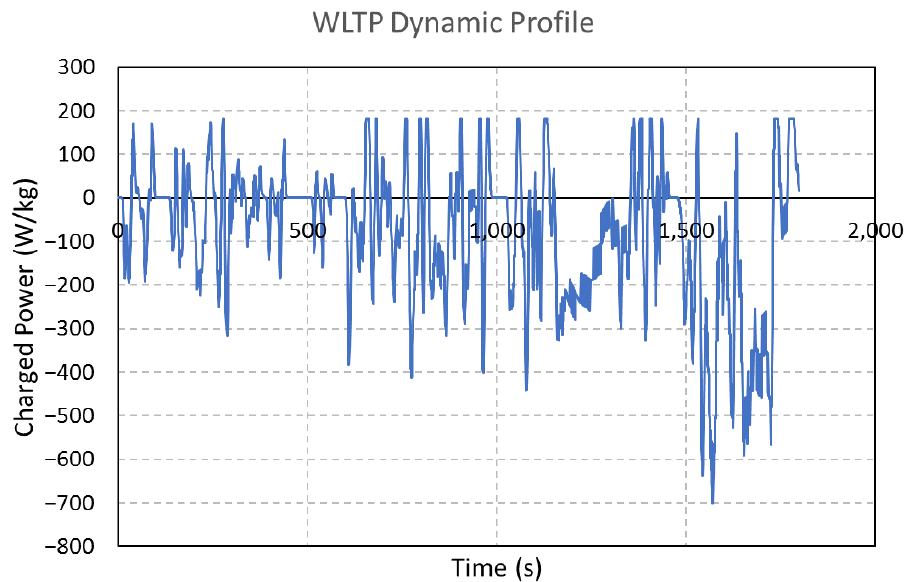
Figure 3. Adaptation of the Worldwide Harmonized Light Electric Vehicle Protocol (WLTP), showing the power profile translated from the speed profile and escalated to a 700 W/kg maximum power.